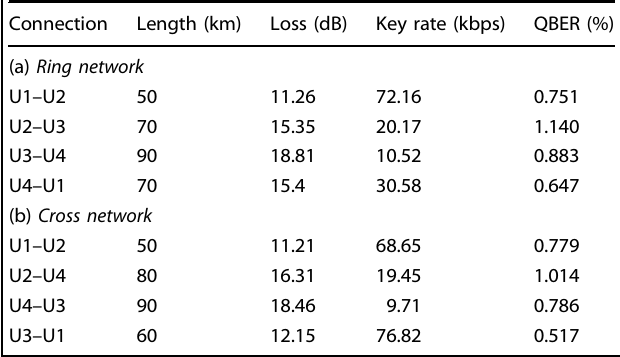
Table 1. Key rates and QBERs of the QKD all-pass network authenticated by the PQC algorithm.